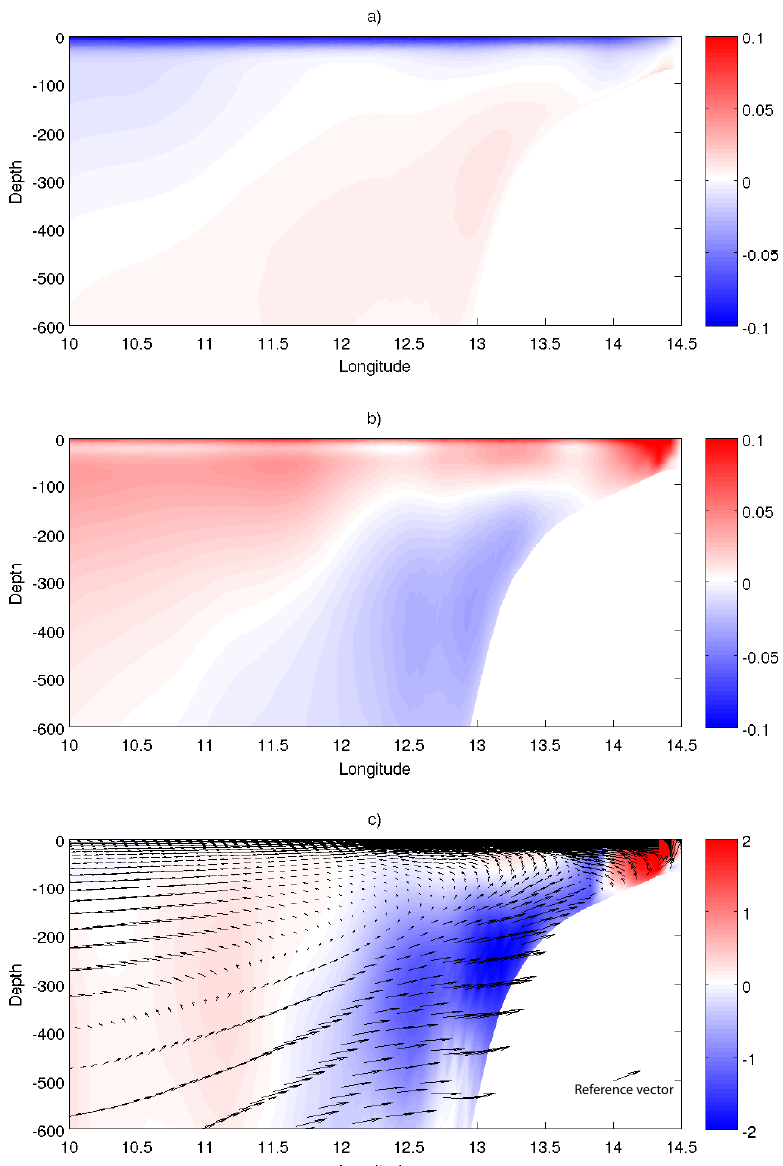
Fig. 3. (a ) Zonal component of velocity (ms − 1 ; positive values indicate eastward direction). (b) Meridional component of velocity (m s − 1 ; positive values indicate northward direction). (c) Zonal and vertical component of total nitrate flux (vectors) and meridional component of total nitrate flux divergence (in color; positive sign represents a nitrate source and negative a sink) (mmolNm − 2 s − 1 ). The reference vector indicates 0.2mmolNm − 2 s − 1 on the x-axis and 0.2 × 10 − 3 mmolNm − 2 s − 1 on the z-axis. Fields are 8yr means, averaged between 22 ◦ S and 24 ◦